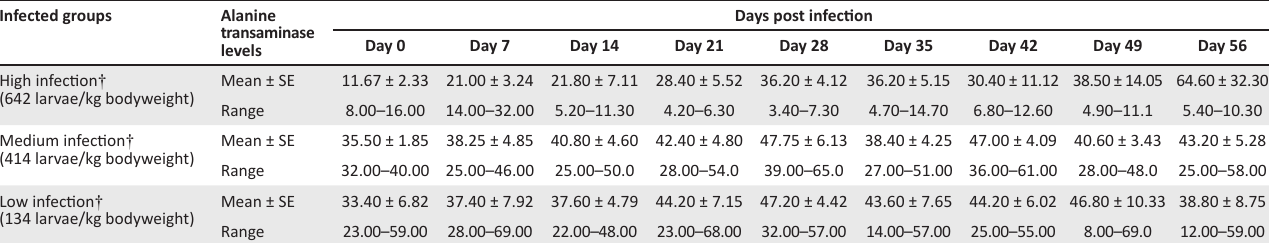
TABLE 3: Mean alanine transaminase levels (IU/L) of Nile crocodiles ( Crocodylus niloticus ) experimentally infected with Trichinella zimbabwensis . Infected